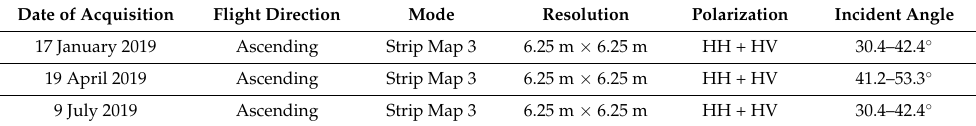
Table 2. Details of PALSAR-2